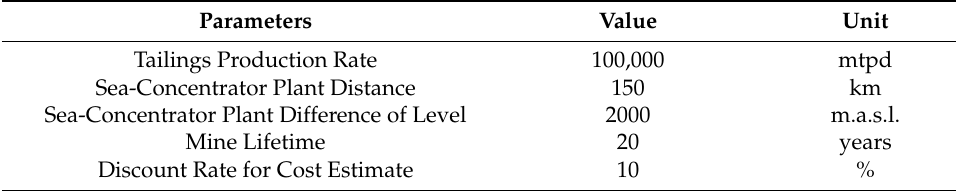
Table 3. Parameters considered for Alternatives Comparison.